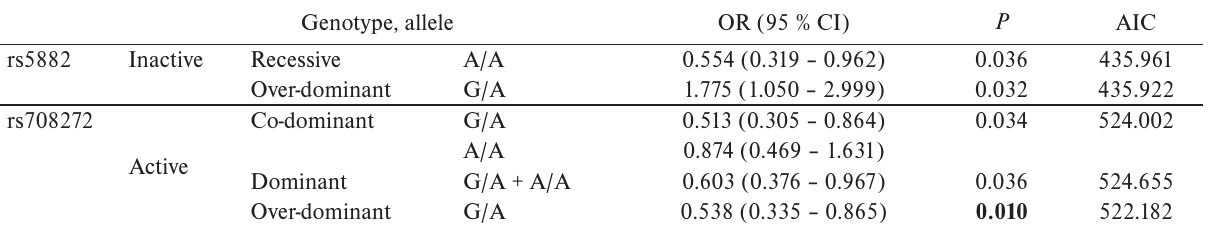
Table 3. Binomial logistic regression analysis of patients with active and inactive PAs and control group subjects. Genotype, allele rs5882